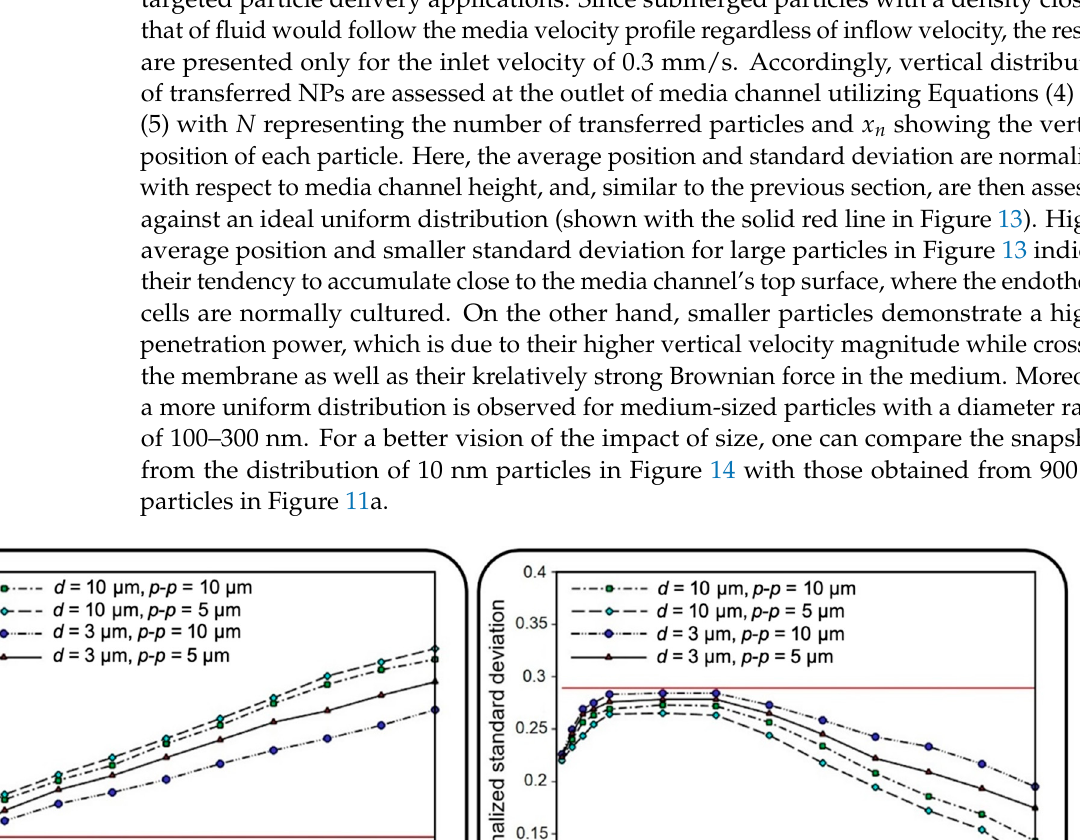
Figure 12. Transfer rate of NPs of diameter ranging from 10 nm to 900 to the media channel of the lung-on-a-chip device with different membrane porosities considering equal inflow velocities of ( a ) 0.3 mm/s and ( b ) 1 mm/s for air and media channels.